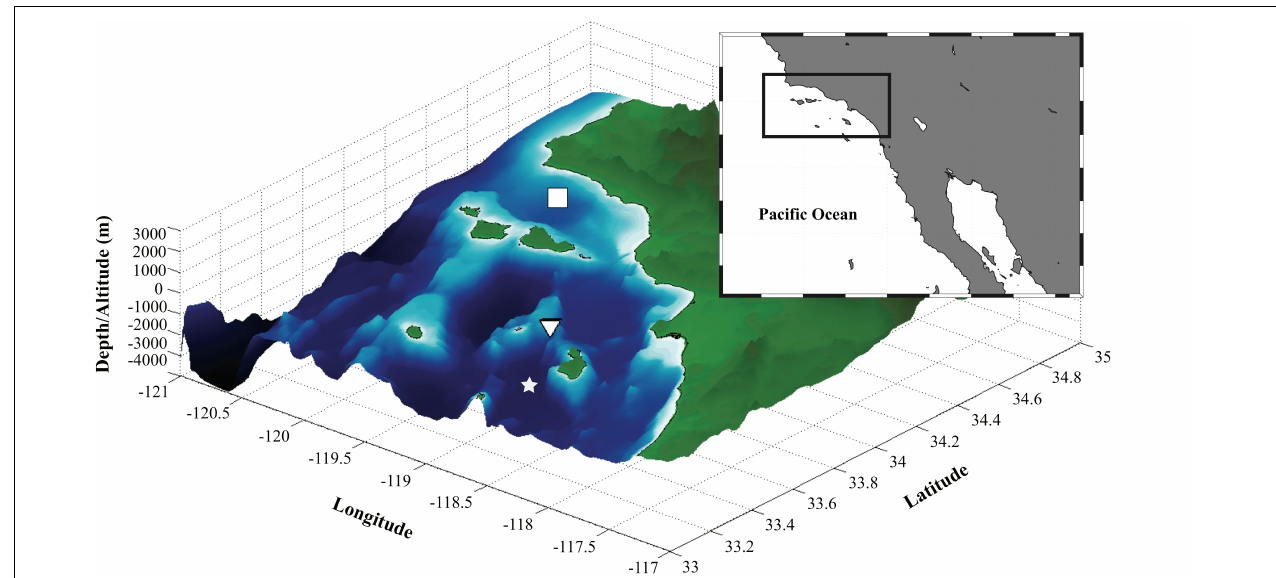
FIGURE 3 | Bathymetry of the study region (area bounded by the solid black rectangle in the inset map). White square indicates the general location of the Santa Barbara Channel sampling sites for the CalEchoes cruise aboard R/V Melville from September 26–October 1, 2010 (see Supplementary Materials ). Inverted triangle represents the site occupied during the FIDO- (cid:56) /O-Cam cruise aboard R/V New Horizon from August 18–23, 2011. White star indicates the location of the Santa Catalina Basin. TABLE 1 | FIDO- (cid:56) /O-Cam cruise “Drop_Profile” information. Drop_Profile Location of Deployment date and Usable Depth PLIF: total images O-cam: total Number Range (m) (from chl- a filter)